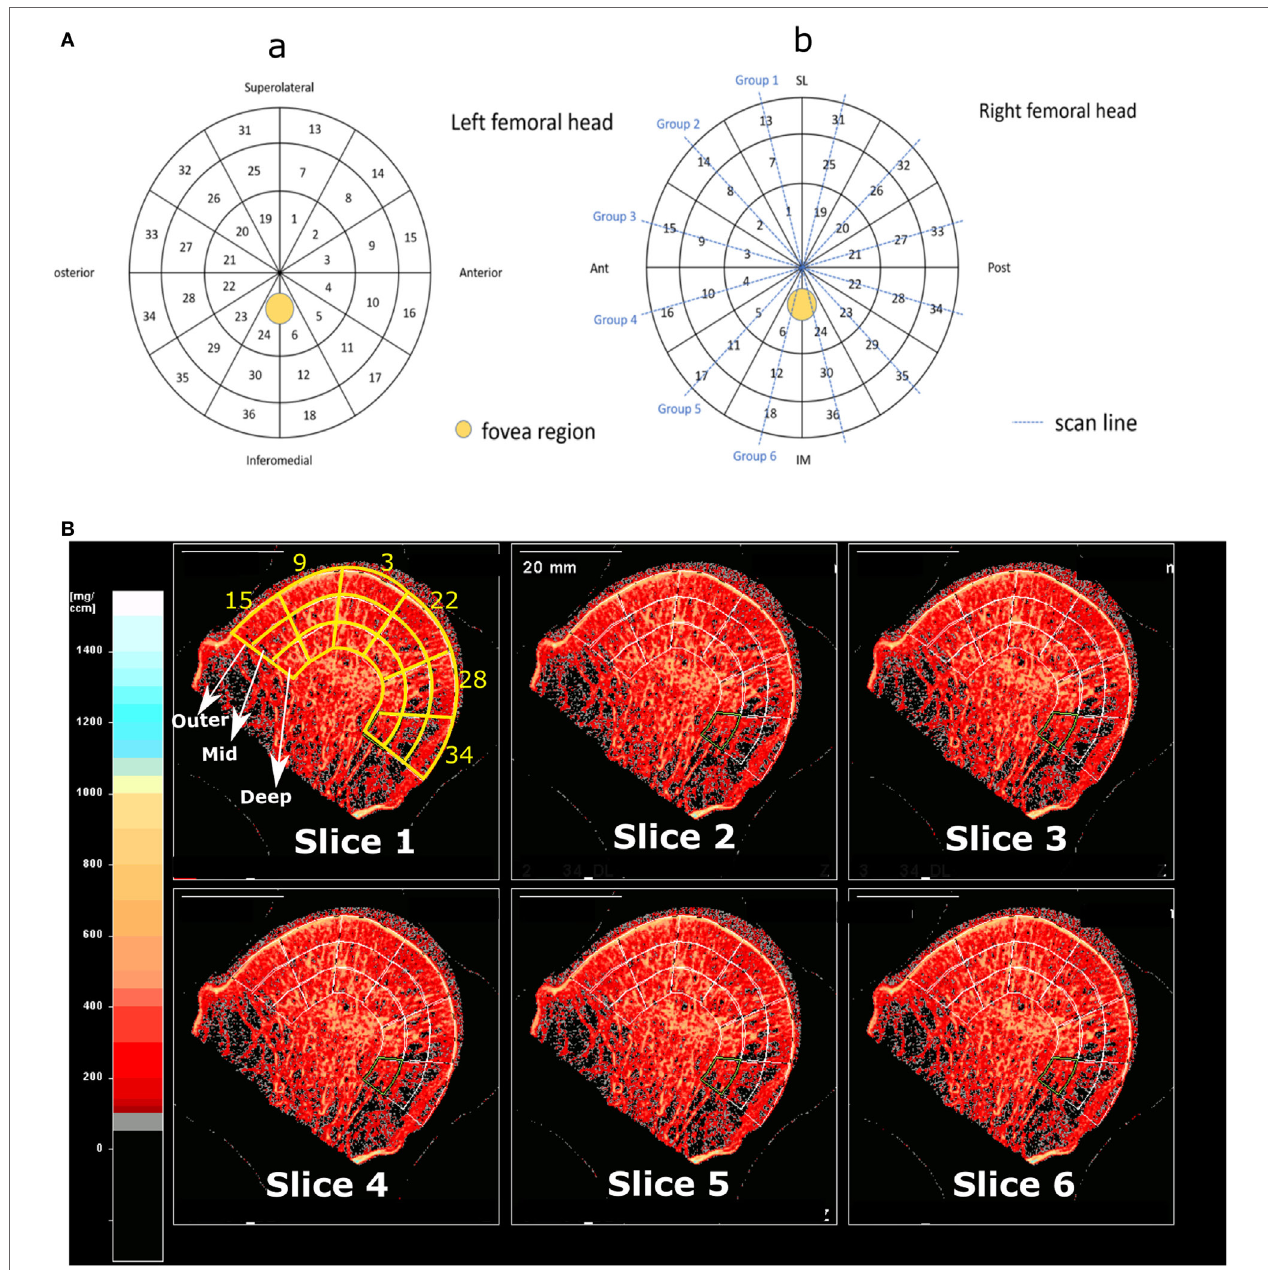
FigUre 1 | (a) Panel (a) shows the different ROIs, birdview from a left femoral head, and panel (b) shows the scan lines on a right femoral head. (B) Shows the three different scan depths across 6 different regions in group 3 , which according to panel (a) are regions 15, 9, 3, 22, 28, and 34. 6 out of 10 slices for this group are